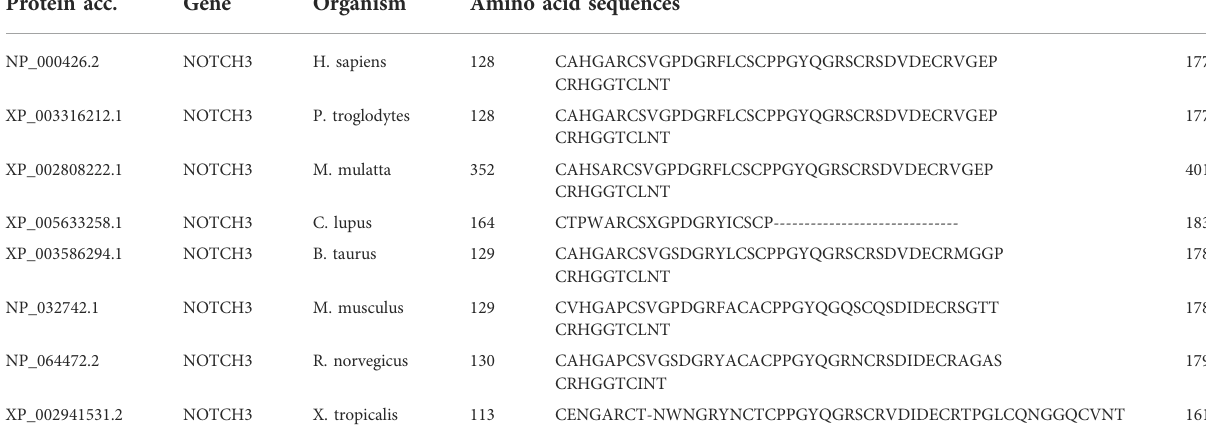
TABLE 2 Evolutionary conservation analysis for the p.Arg133Cys mutation in NOTCH3. Protein